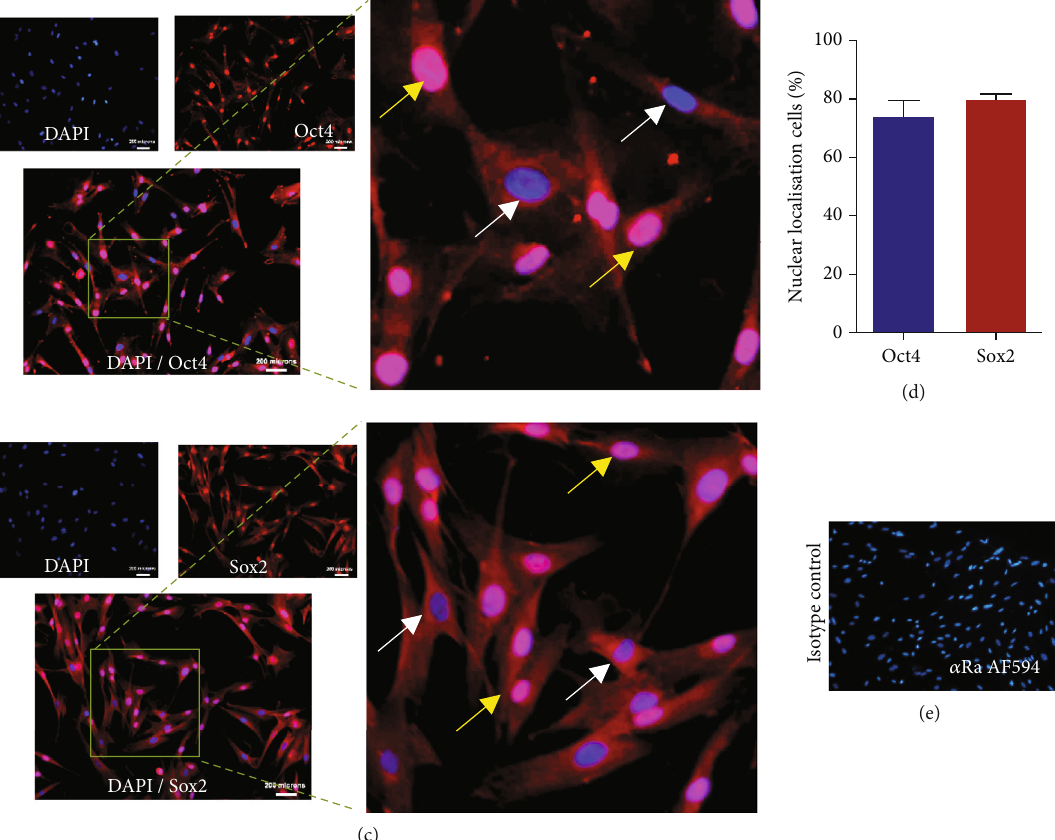
Figure 1: Expression pro fi le of WJ-MSCs. Panel A: representative fl ow cytometry pro fi le of WJ-MSCs depicting percentage of cells expressing the CD markers of interest are shown within each histogram. Blue histogram represents cells stained with the CD marker of interest, whereas Pink histogram represents cells stained with isotype control. Panel B: percentage of cells sowing the expression of respective CD markers ( mean ± SEM , n = 3 ). Panel C: representative immuno fl uorescence image of WJ-MSCs showing the expression of pluripotent markers Oct4 and Sox2. Panel D: percentage of cells with nuclear localization of Oct4 and Sox2 ( mean ± SEM , n = 3 ). Panel E: isotype control for anti-rabbit